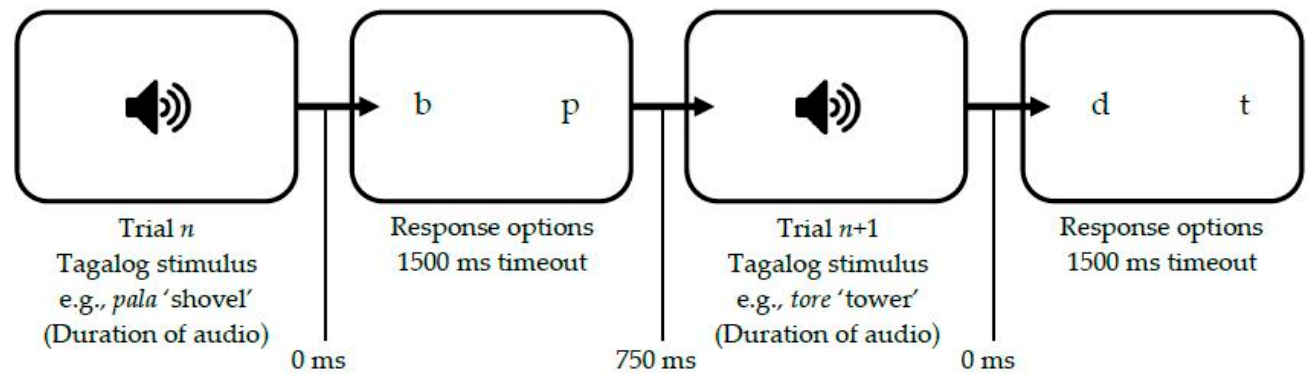
Figure 2. Trial design for condition 1 (crosslinguistic mapping).